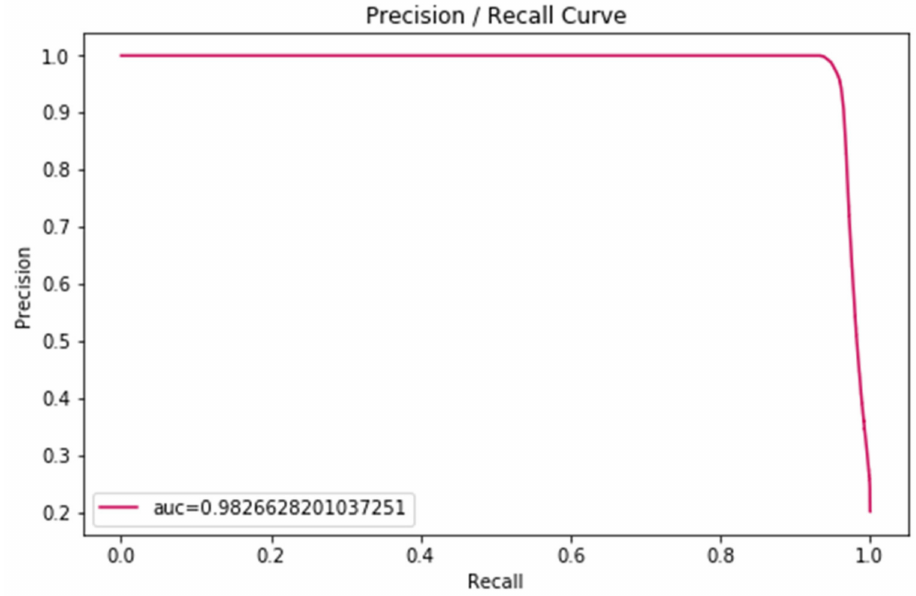
Figure 9. Precision-recall curve with average precision/recall score ≈ 98.27%.